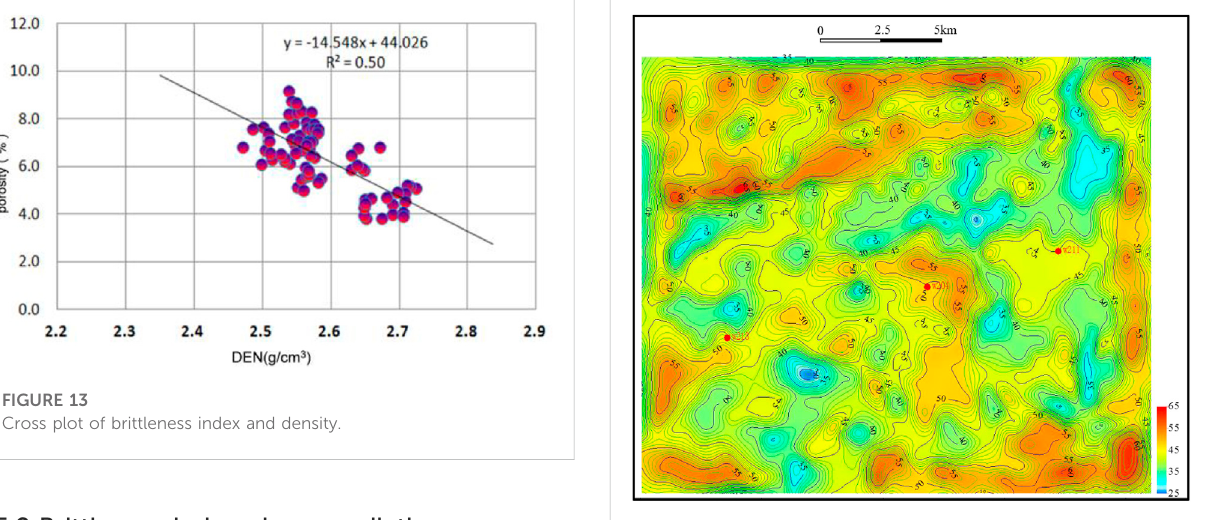
FIGURE 14 Planar distribution map of brittleness index in W204 well